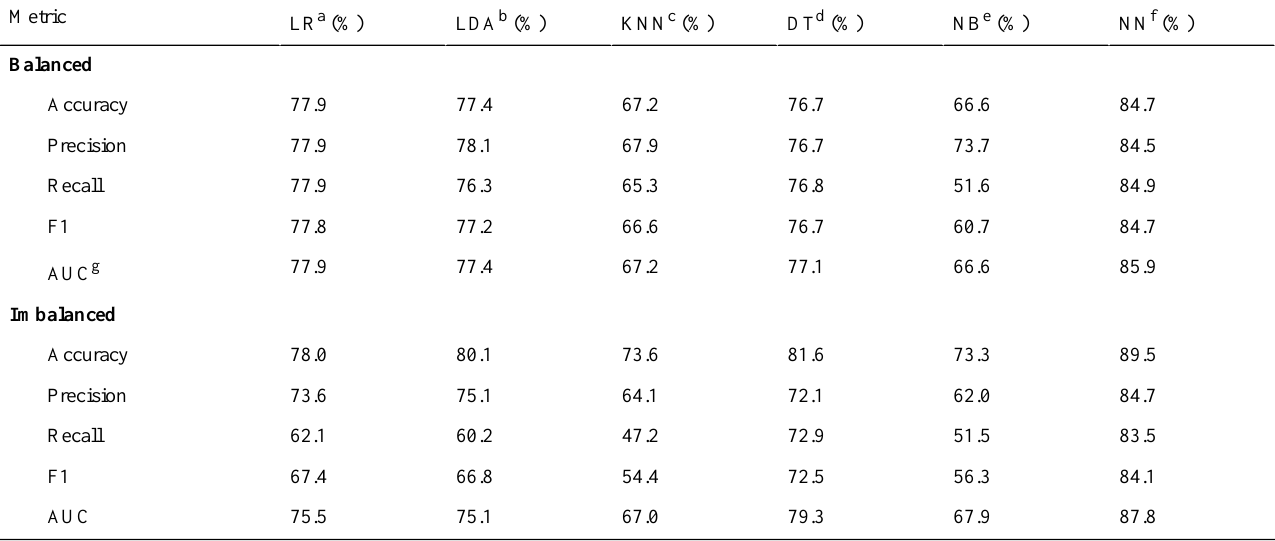
Table 8. Electronic intensive care unit classification performance in traditional